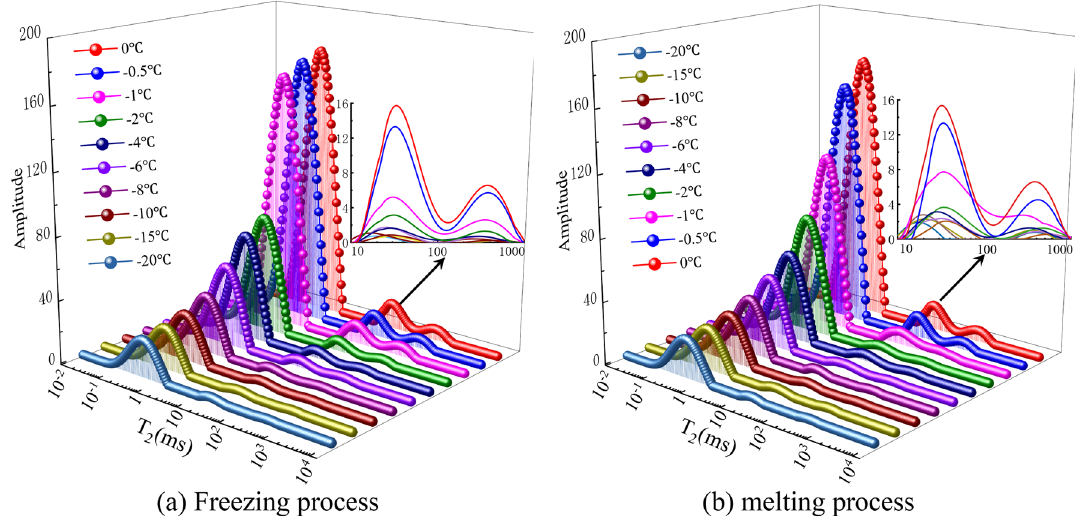
Figure 8. T 2 distribution curve of coal sample A during